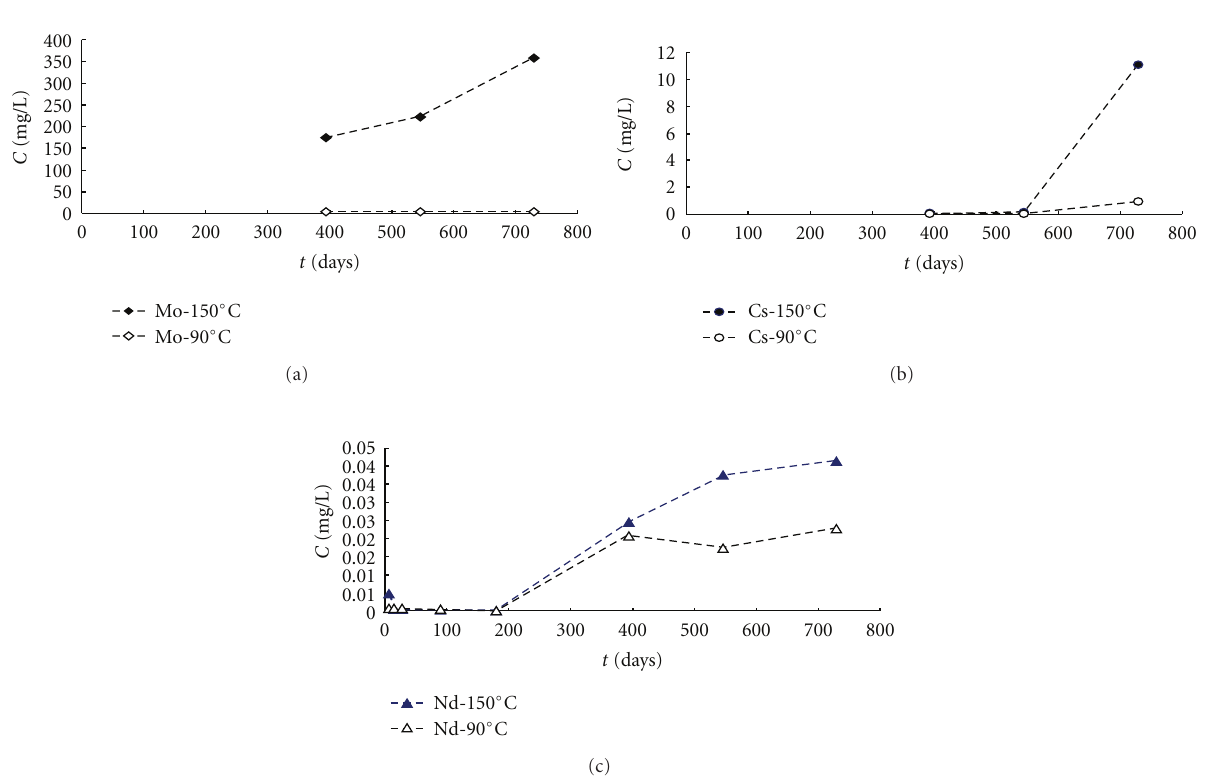
Figure 2: The leaching of the glass network forming elements.